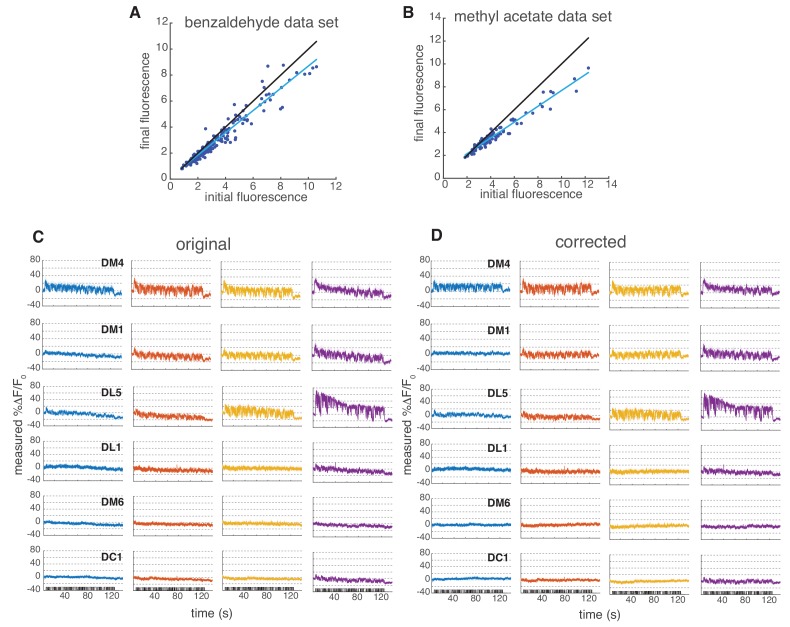
Linear correction to Syp-pHTomato fluorescence.(A–B) Data for main Figure 6E and F were collected in two experimental sessions. In both cases, we noticed a drift in fluorescence probably due to bleaching of the sensor. Here, we show a scatter plot of the initial versus final baseline fluorescence (in a.u.) in the two experimental sessions for all single measurements taken (all glomeruli at all concentrations in all flies). We estimated a linear drift of 0.85 in the benzaldehyde data set and 0.7 in methyl acetate data set from the slope of the linear fit (blue line; black line indicates identity). Notice that the drift affected also non-responsive glomeruli, therefore is independent of odor response. (C) Mean change in fluorescence from 6 glomeruli at four concentrations. Shaded error bars indicate SEM. (D) Mean change in fluorescence after linear correction to the raw data.